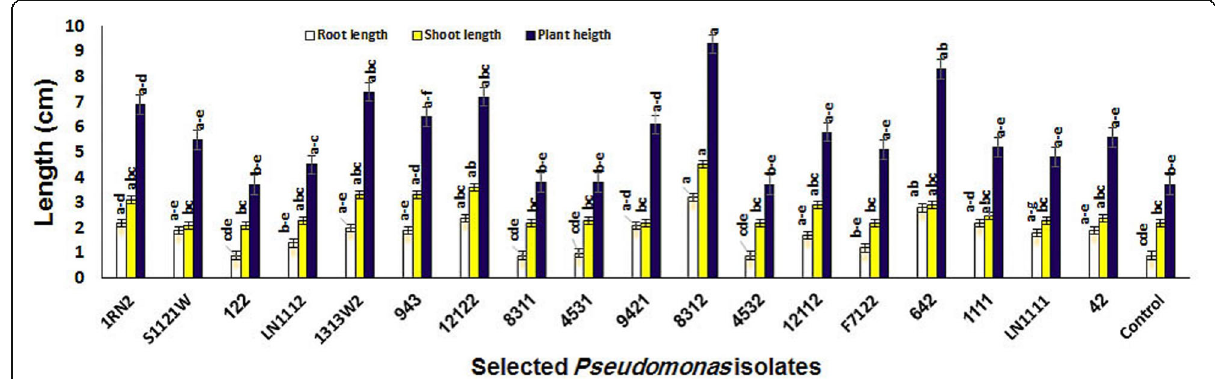
Fig. 5 Effect of canola seed priming by selected Pseudomonas isolates on root, shoot and plant length of canola in greenhouse conditions. Each